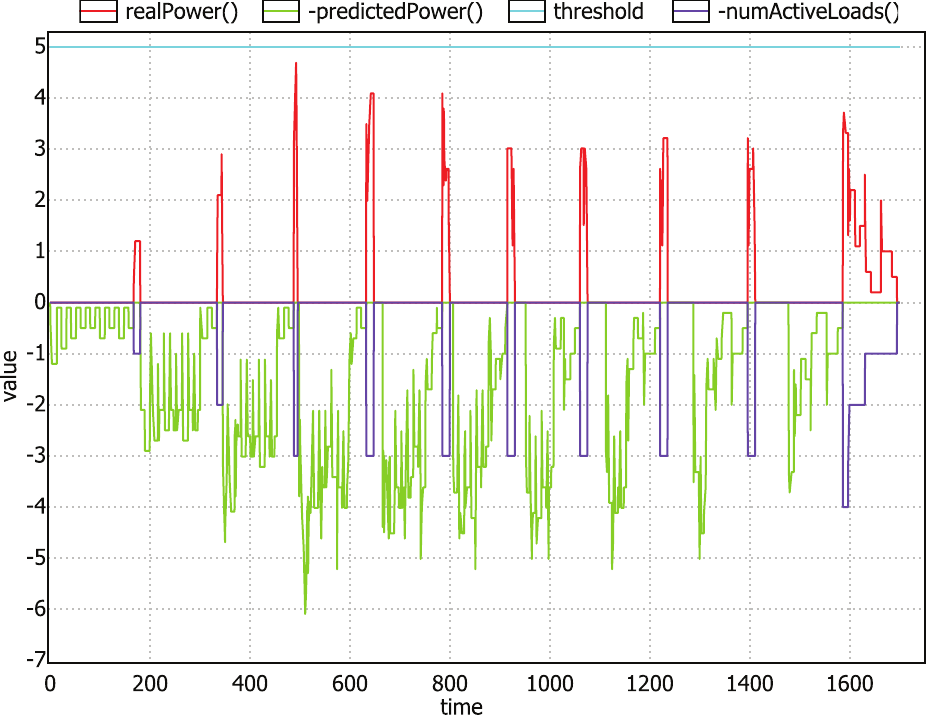
Figure 11. The real power and predicted power consumption (in KW) and number of active loads during load scheduling with a threshold of 5 (KW).